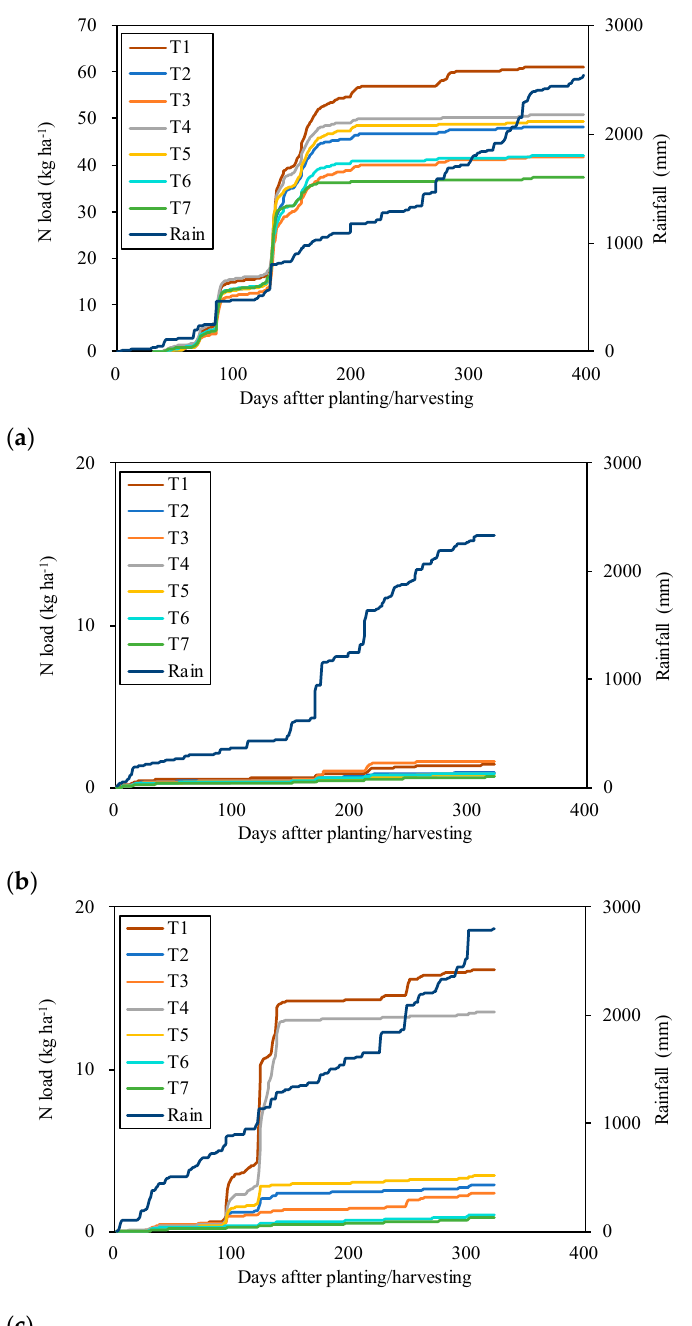
Figure 6. Cumulative rainfall and N loads in deep drainage under different N treatments: ( a ) season 1; ( b ) season 2; and ( c ) season 3. Treatments (T1–T7) refer to the different N application rates shown in Table 2.